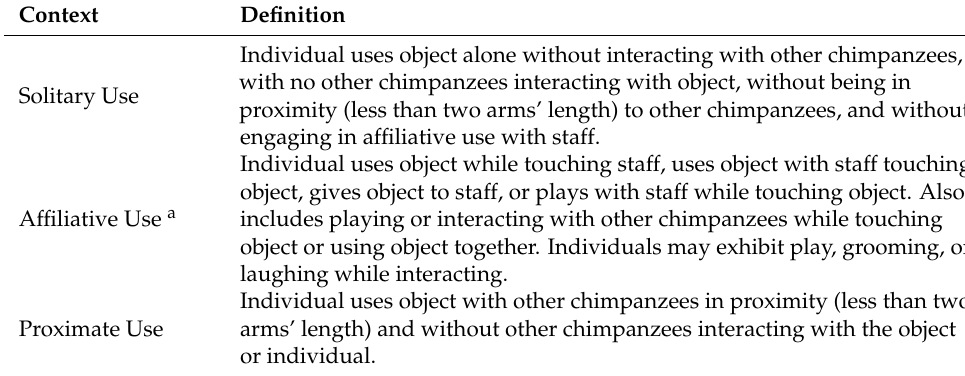
Table 4. Social context of enrichment use